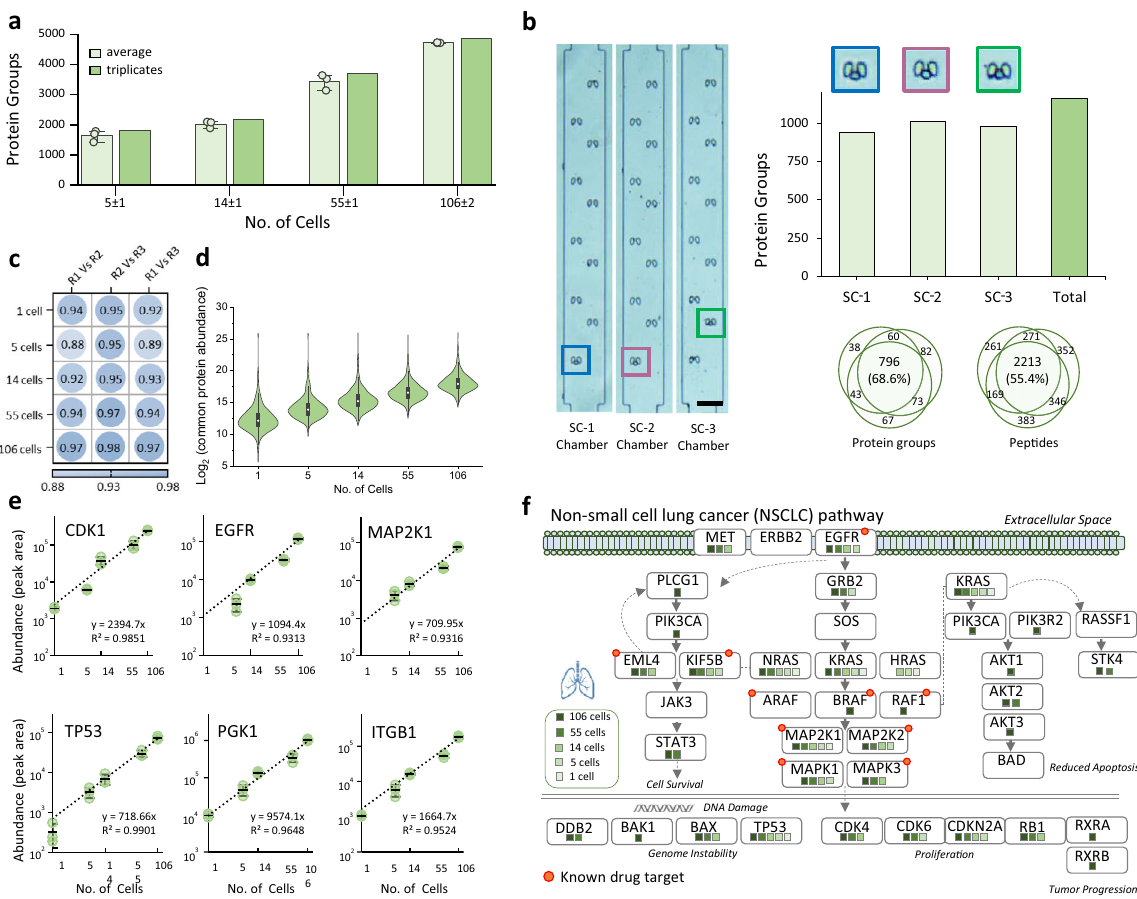
Fig. 4 Analytical performance in sensitivity, reproducibility, and quantitation in proteomic pro fi ling of a lower number of cells by iProChip-DIA. a Identi fi cation summary of protein groups across different PC-9 cell numbers by iProChip-DIA. Data are presented as mean values± SD ( n = 3 independent cell samples for each condition). b Single PC-9 cell trapping using 10 cell capture chambers and corresponding cell image and triplicate analysis results of identi fi ed protein groups and coverage. SC: single cell; scale bar: 100 μ m. c A heatmap showing the reproducibility of protein abundances obtained among different cell numbers and their replicates (R1 – R3). d Distributions of total protein abundances in commonly identi fi ed proteins across different cell numbers. Each data was analyzed in n = 3 independent measurements. Center lines show the mean; box limits indicate the 25th and 75th percentiles; whiskers, 1.5× interquartile range. e Representative examples of lung cancer-related proteins showing quantitation of protein abundance calculated from peak area. Data are shown as mean ± SD from n = 3 independent measurements. f Identi fi cation coverage of proteins within the NSCLC pathway under different cell numbers using Kyoto Encyclopedia of Genes and Genomes (KEGG) database. Source data are provided as a Source data fi